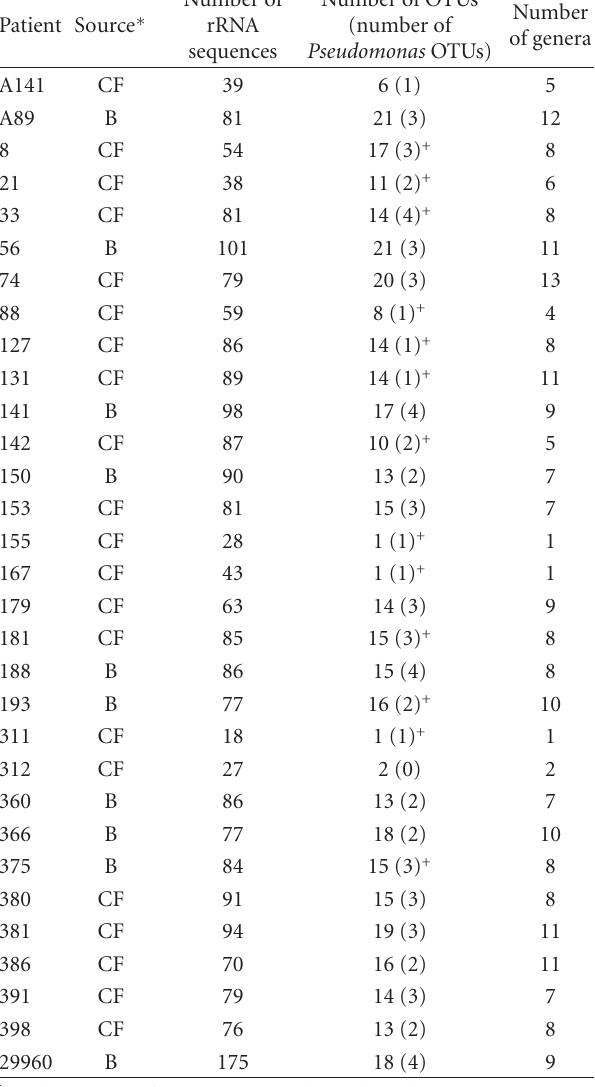
Table 1: Sequences and OTUs for each patient.